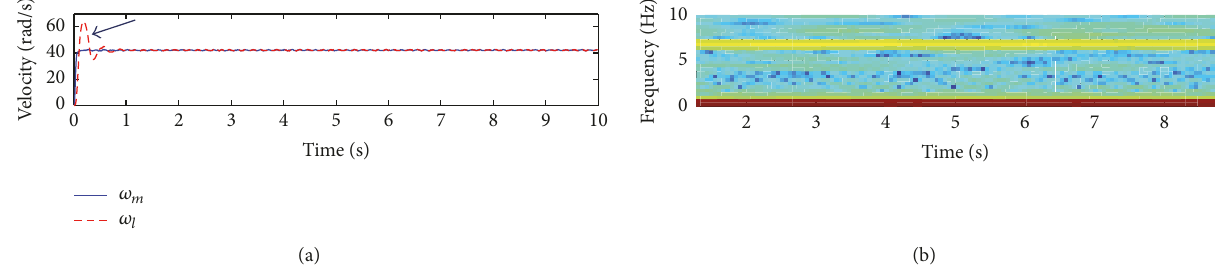
Figure 12: (a) Velocity response of the drive side and the load side when 𝑞 = 0.131 and spring 4 are chosen. (b) The time-frequency spectra of the velocity of the drive